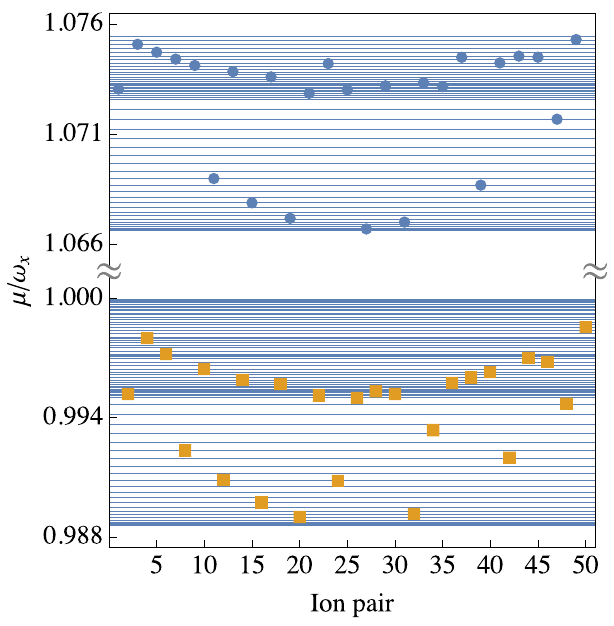
FIG. 10. Pulse optimization in a finite chain. We show the cho- sen detunings (see main text) to implement a dense circuit of 50 parallel, maximally entangling tweezer gates in a chain of 130 ions with 15 buffer ions on each side ( p = 4, ν 0 = 0.4, (cid:14) ≈ 0.07). The horizontal lines mark the mode frequencies. We allow S = 8 segments and set the gate duration to ω x τ = 1500, which requires a maximal Rabi frequency of η 0 (cid:4)/ω x = 0.007. We get average infidelity δ F = 10 − 5 and crosstalk C = 2.77 × 10 − 4